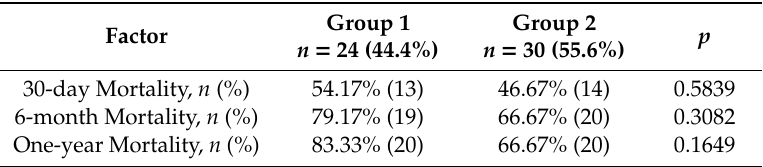
Table 5. Mortality in STEMI